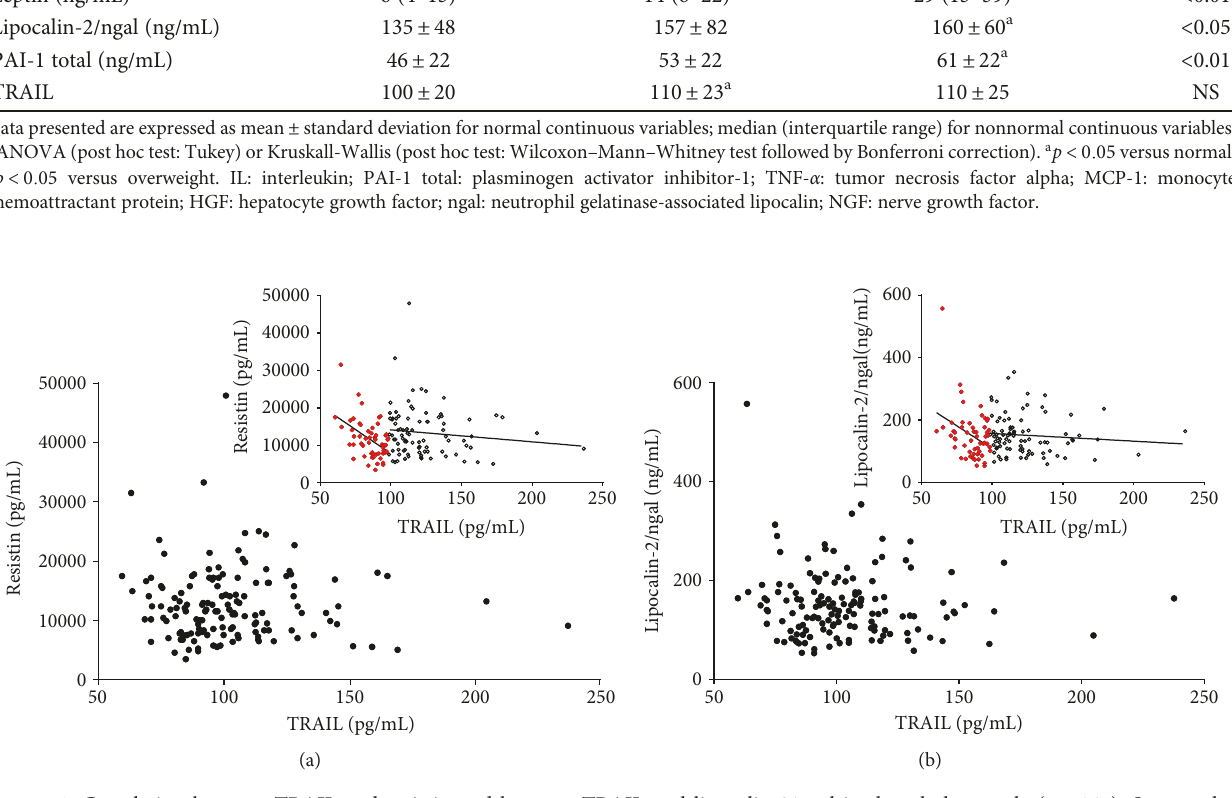
Figure 1: Correlation between TRAIL and resistin and between TRAIL and lipocalin-2/ngal in the whole sample ( n = 147 ). Scatter plot showing the relationship between the circulating levels of TRAIL and resistin (a) and between circulating levels of TRAIL and lipocalin- 2/ngal (b) in the whole cohort of samples. Insets show the two di ff erent relationship between TRAIL and resistin (inset in (a)) and between TRAIL and lipocalin-2/ngal (inset in (b)) after division of the whole population in two groups according to the upper limit of TRAIL decile IV (TRAIL: 98.59pg/mL). Empty square data points=samples with TRAIL levels higher than TRAIL decile IV; full red circle data points=samples with TRAIL levels lower than TRAIL decile